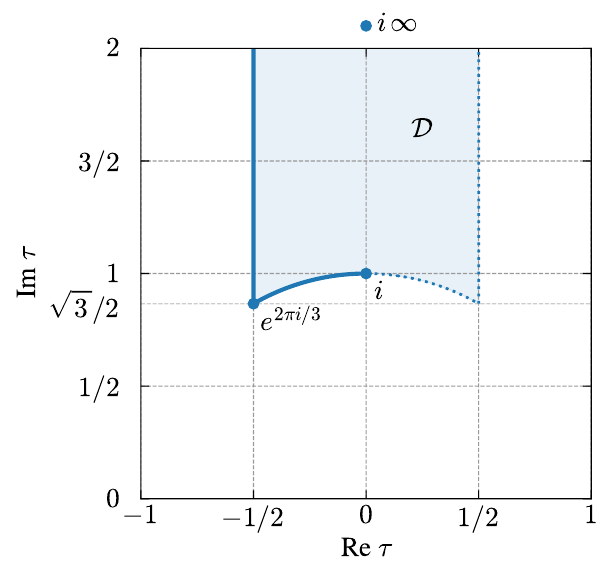
Figure 1 . The fundamental domain D of the modular group Γ and its three symmetric points τ sym = i ∞ , i, ω . The value of τ can be restricted to D by a suitable modular transformation. (figure from ref.